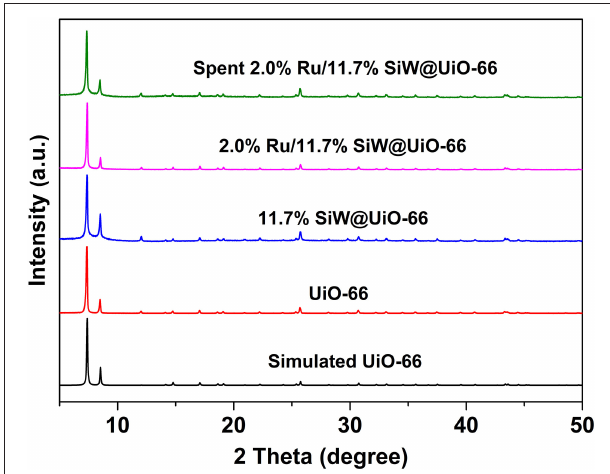
FIGURE 1 | XRD patterns of various tested